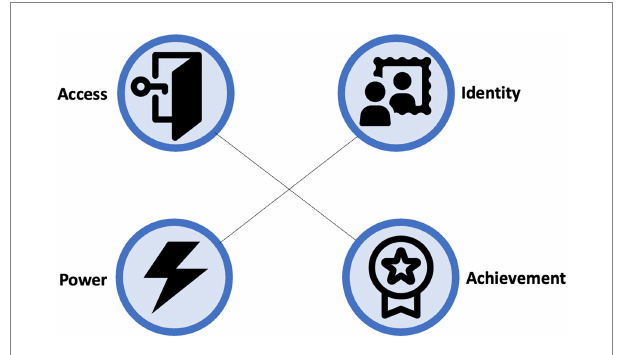
FIGURE 1 Four dimensions of equity (re-created from Gutiérrez,